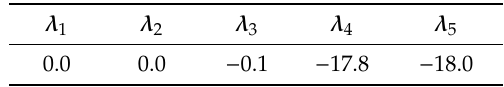
Table 2. Values of Lyapunov Exponents for Step Tracking